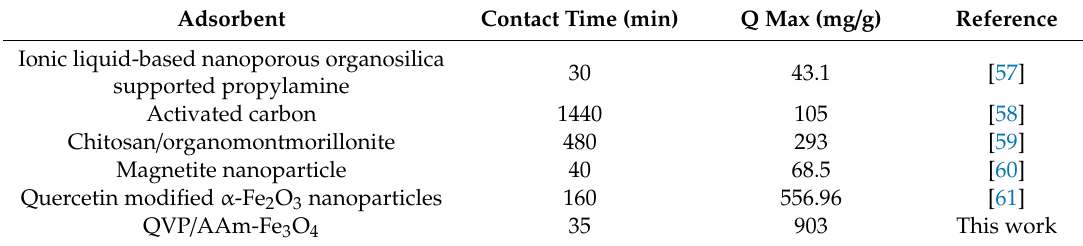
Table 4. Adsorption performance comparison of various